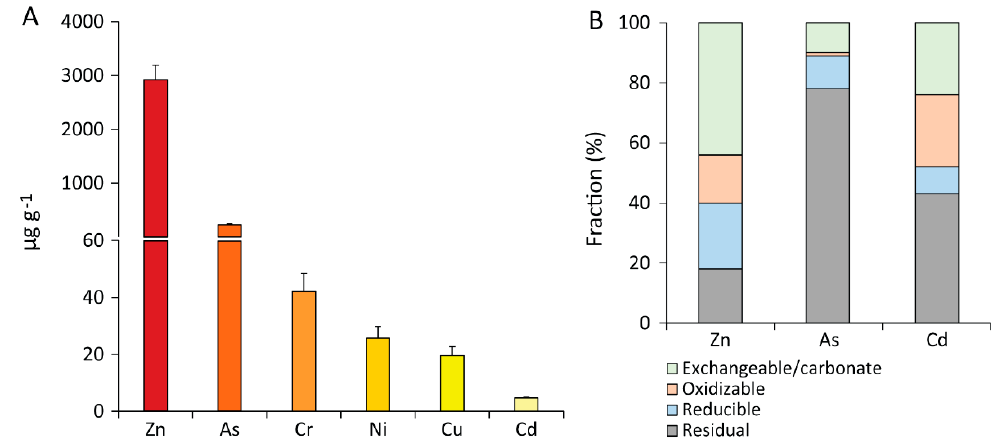
Figure 1. Total concentrations of metals and their repartition into the different geochemical phases in the sediments of Portman Bay. In the left panel ( A ), reported are the concentrations of the main HMs found in the sediments collected for the setup of the bioremediation experiments. In the right panel ( B ), reported is the partitioning of each HM in the four geochemical fractions (exchangeable, oxidizable, reducible, residual) for the three elements found to exceed sediment quality guidelines and hence further selected as targets for our bioremediation tests. Reported are average values and SDs.